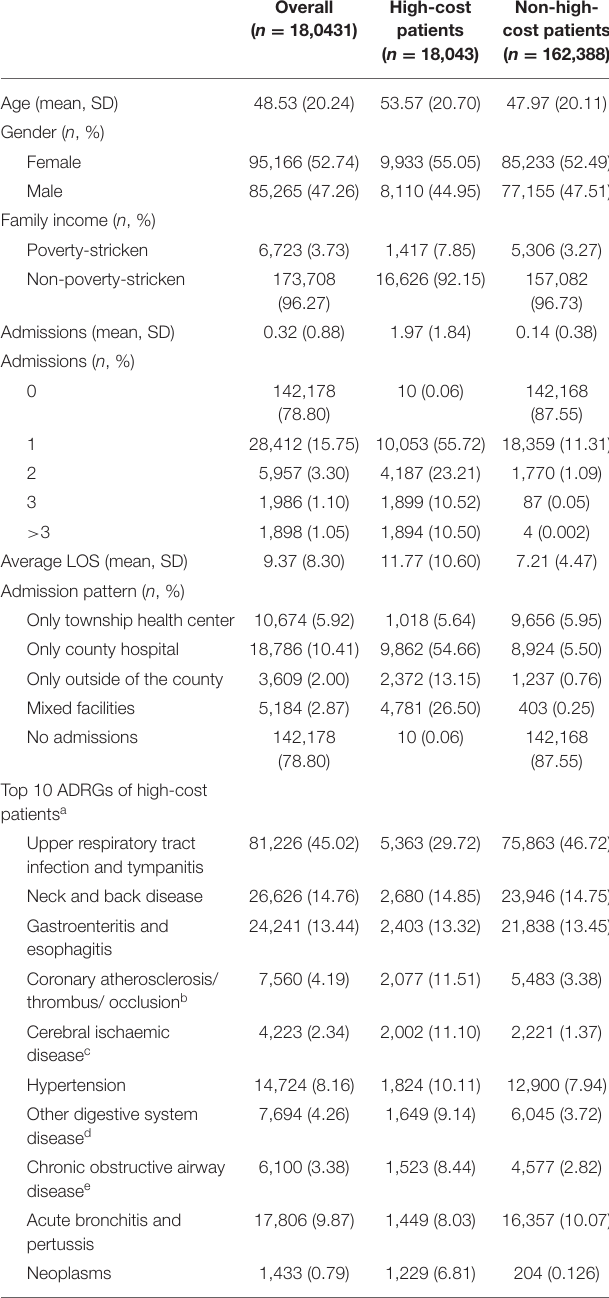
TABLE 1 | Characteristics of overall, high-cost and non-high-cost